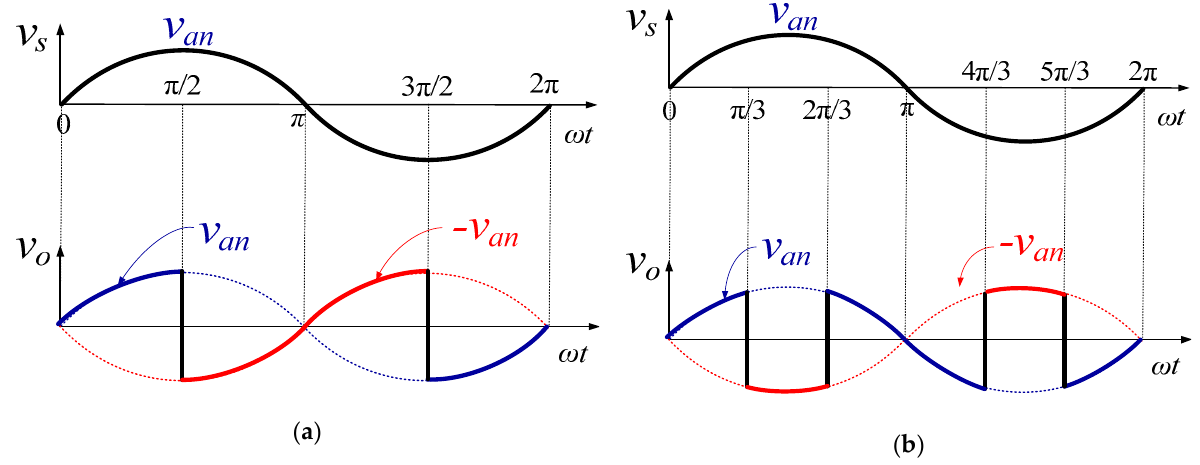
Figure 7. Variable frequency outputs with respect to input ( a ) double frequency and ( b ) triple frequency.